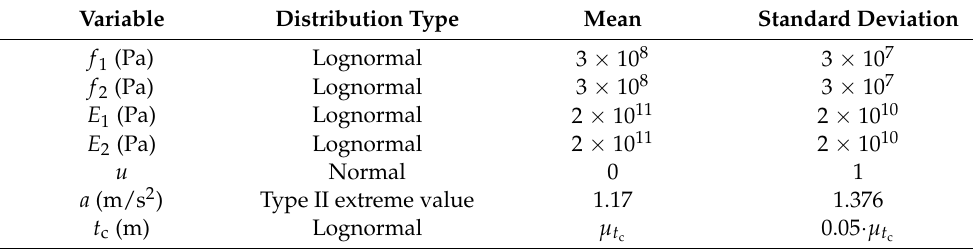
Figure 4. Three-storey steel frame. ( a ) Schematic. ( b ) Material model of steel. Table 2. Random design variables and parameters in Example